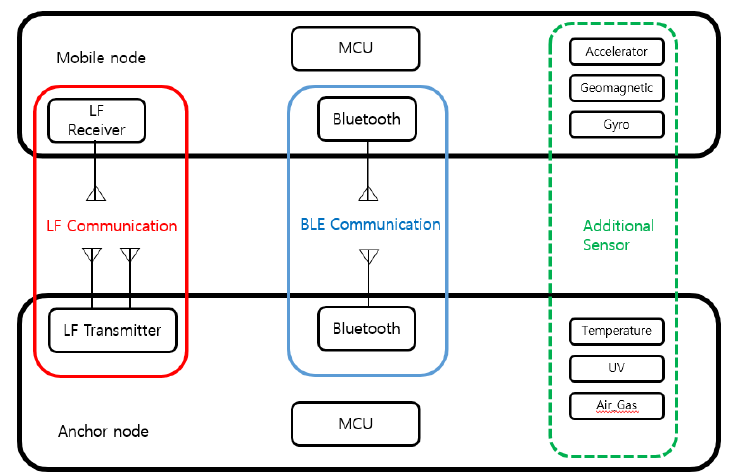
Figure 3. Communication blocks of nodes of the hybrid SAIL System.